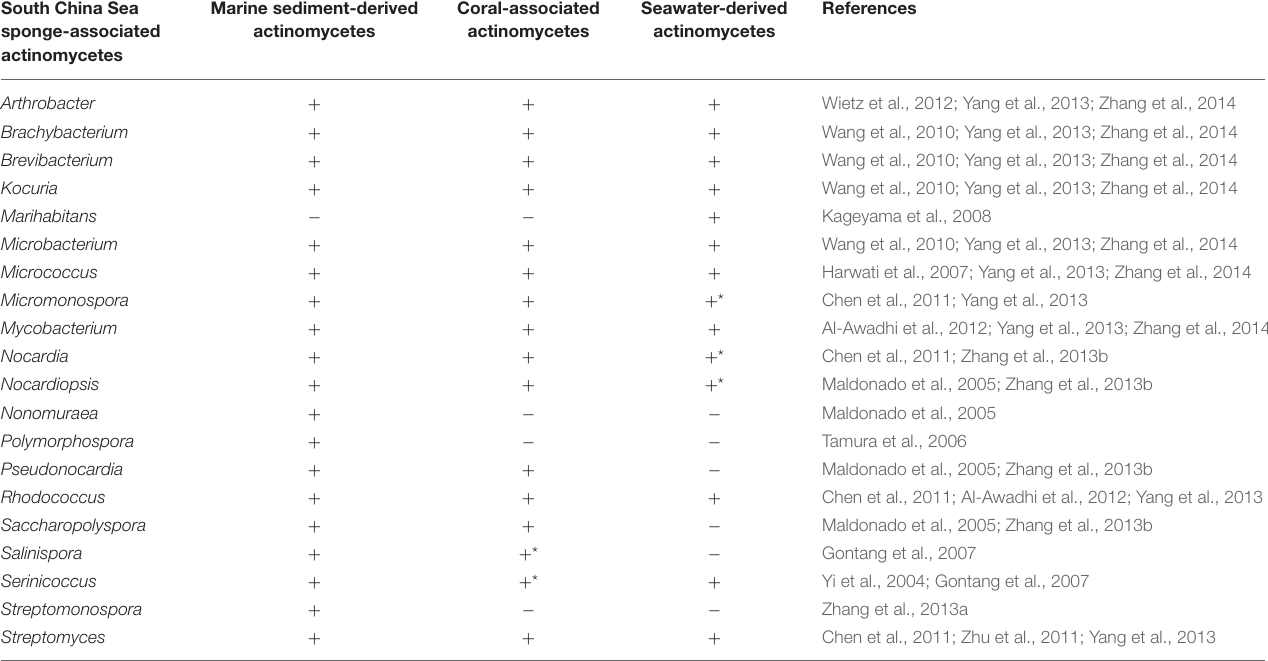
TABLE 4 | Comparison of the culturable diversity of South China Sea sponge-associated actinomycetes with that of marine sediment-derived, coral-associated, and seawater-derived actinomycetes. South China Sea